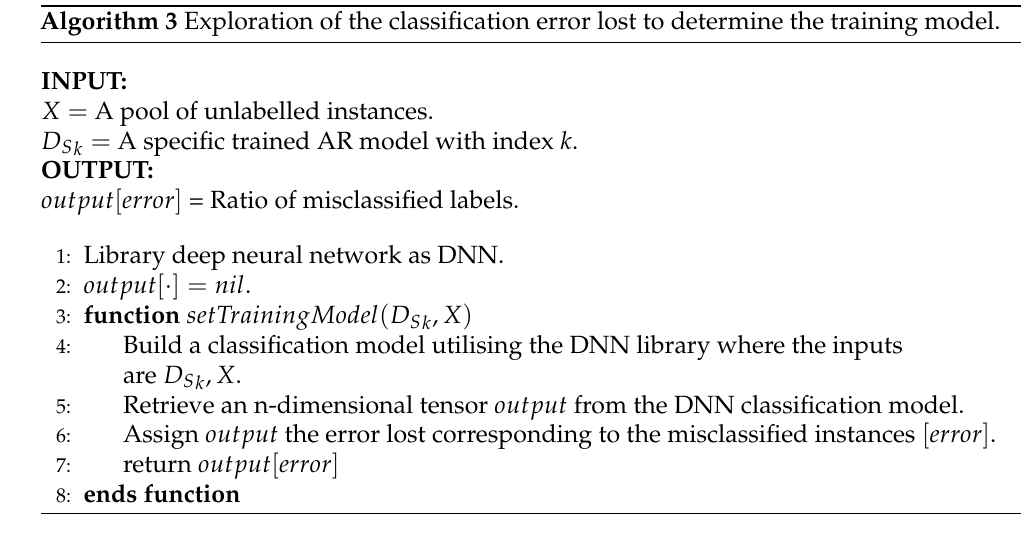
Algorithm 3 Exploration of the classification error lost to determine the training